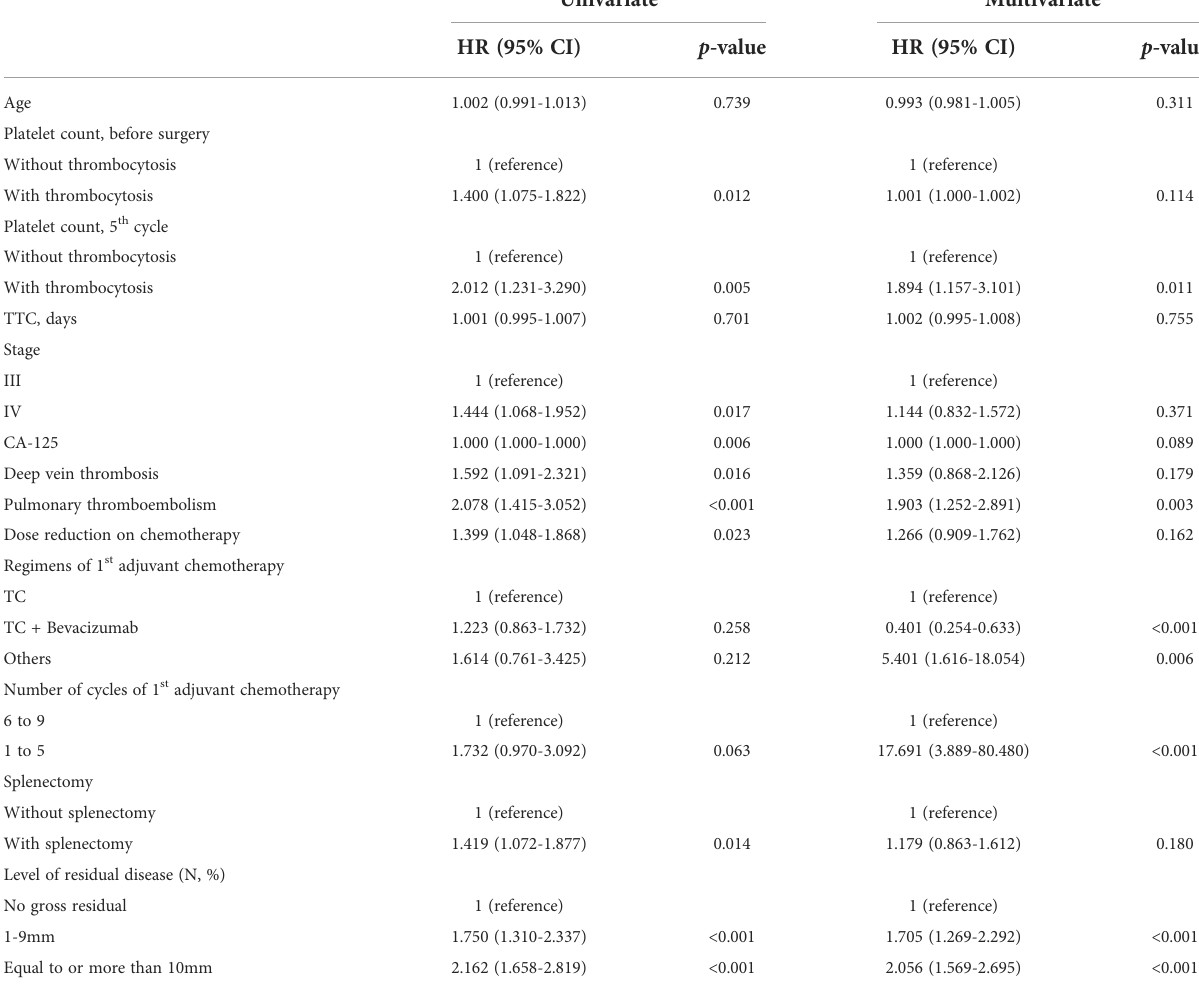
TABLE 3 Univariate and multivariate analysis for progression free